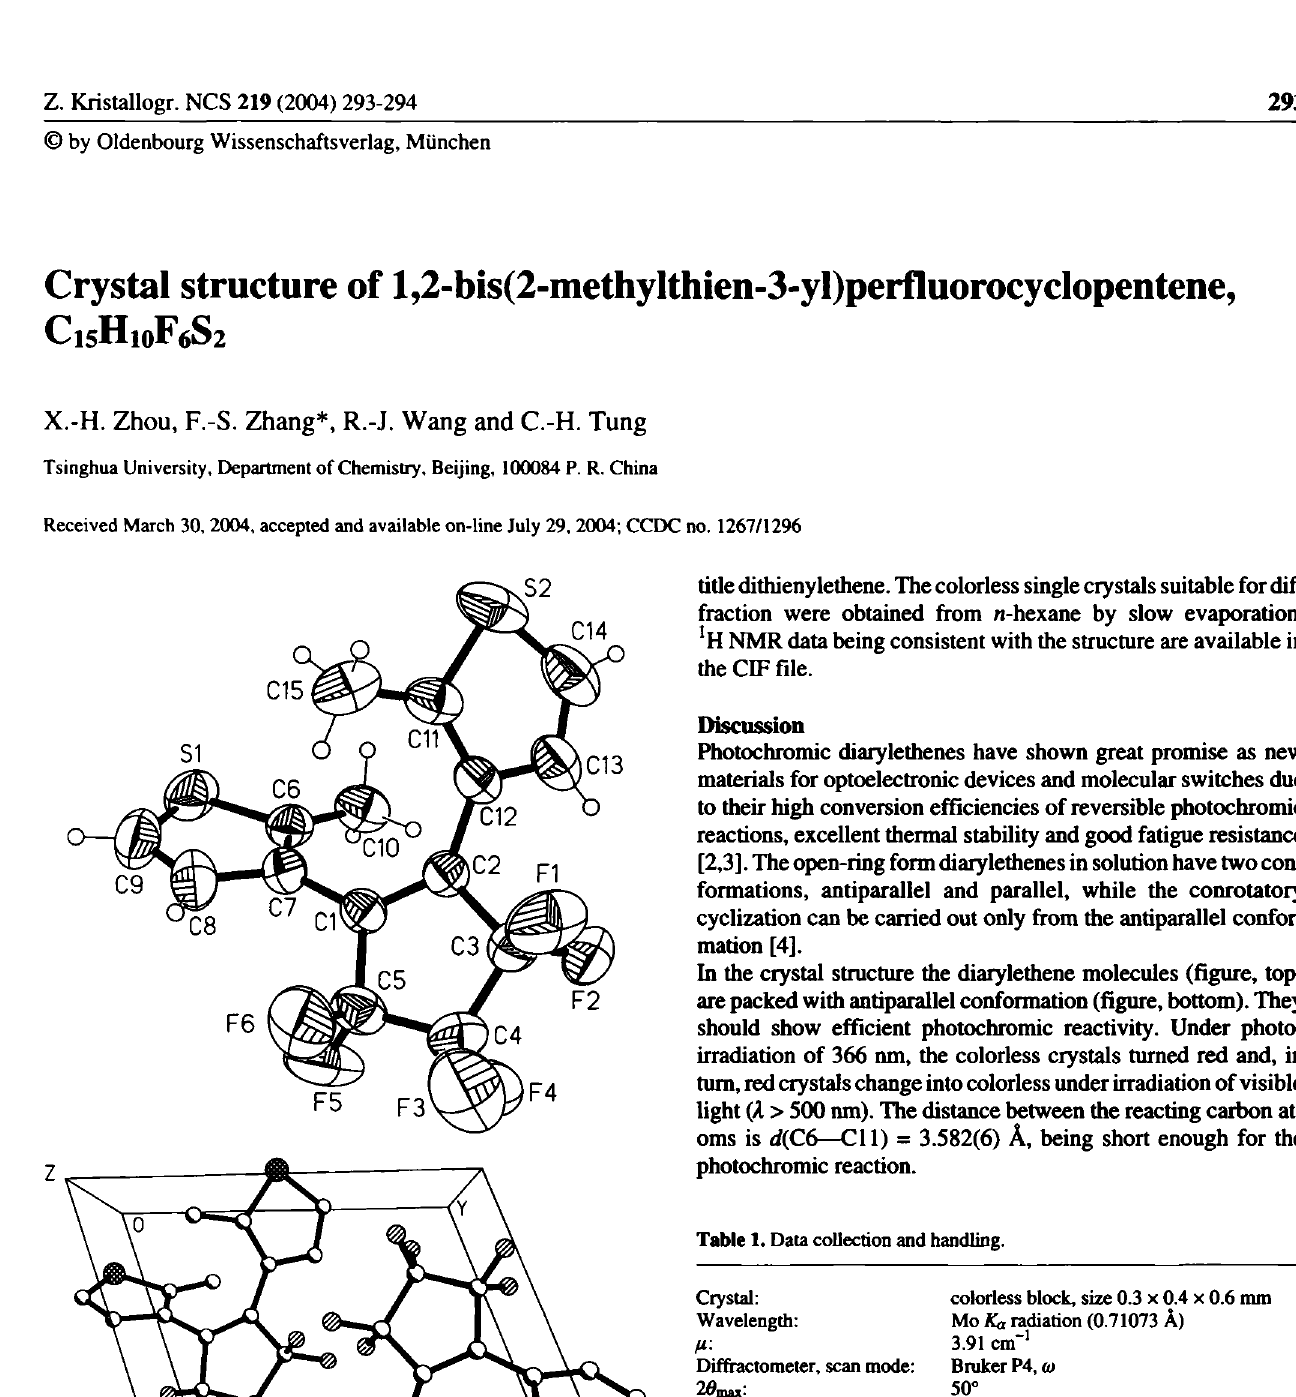
Table 2. Atomic coordinates and displacement parameters (in Â 2